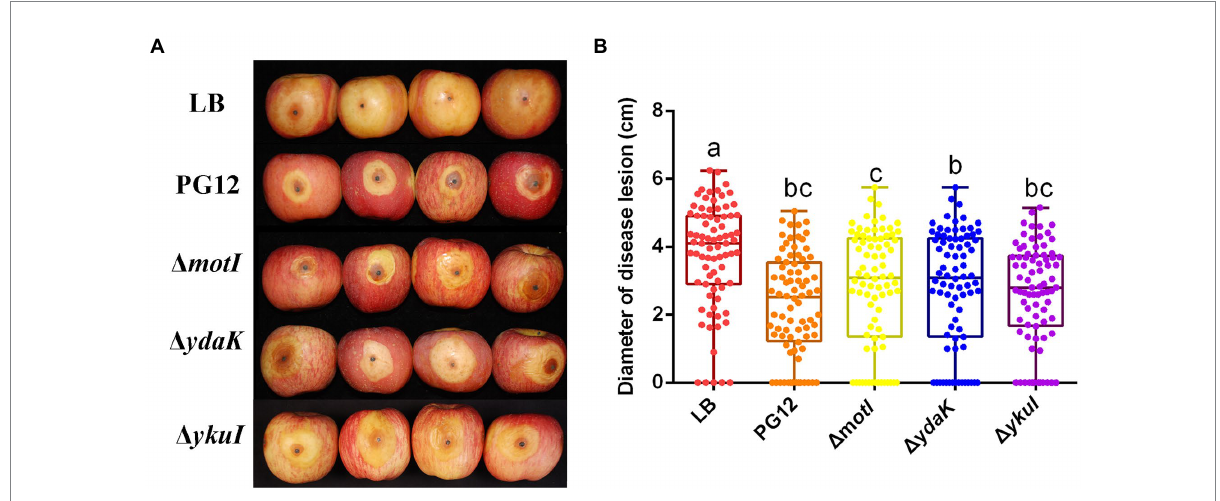
FIGURE 7 Deletion of the potential c-di-GMP receptors does not affect the biocontrol efficacy of B. velezensis against apple ring rot disease. Bacteria were incubated for 48 h in LB broth. Biocontrol efficacy was assessed with Fuji apple fruits treated with the cultures of B. velezensis PG12(PG12), Δ motI , Δ ydaK , or Δ ykuI . LB broth (LB) was used as control. Images were taken (A) and the diameter of disease lesions (B) was measured 7 days post inoculation. Values correspond to the mean diameter of 80 disease lesions from 20 apple fruits. The data is a representative of three independent experiments. Different letters on the column indicate significant differences between different treatments according to the least significant difference (LSD) test ( p < 0.05).